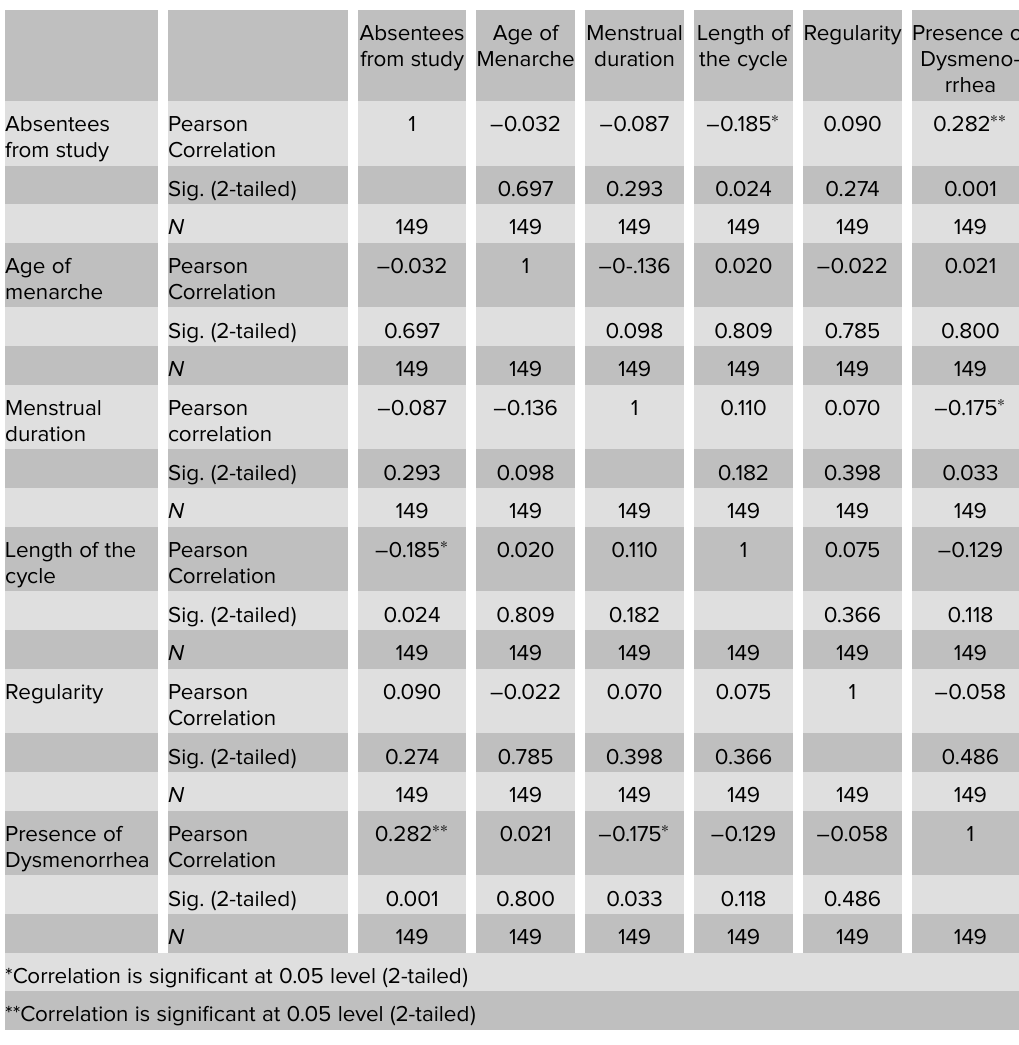
TABLE 3: Correlations between absentness from study and different menstrual problems (n=149)